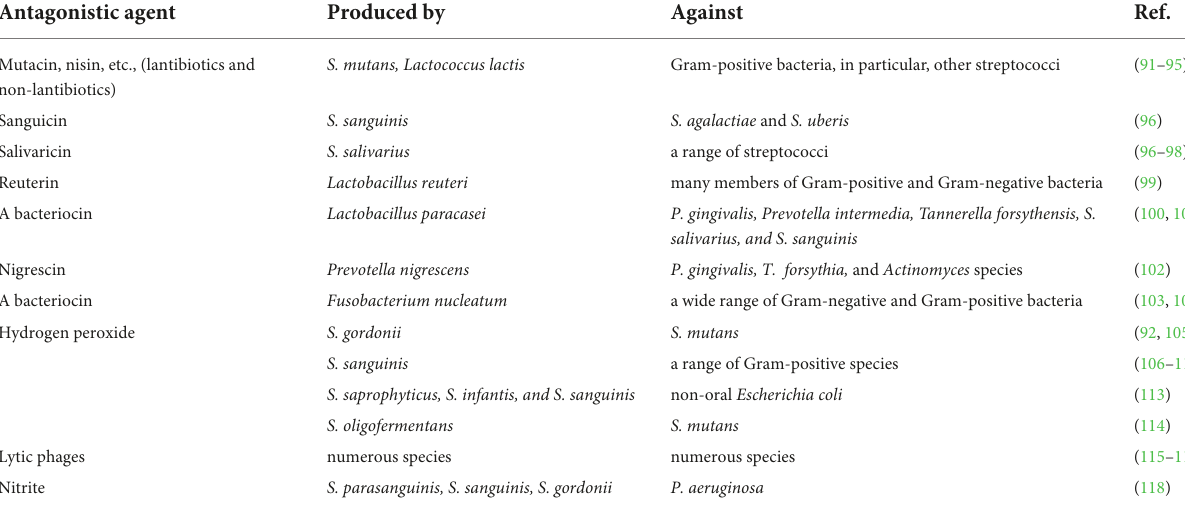
TABLE 3 Production of inhibitory factors by the resident oral microflora that contribute to “colonization resistance”. Antagonistic agent Produced by Against